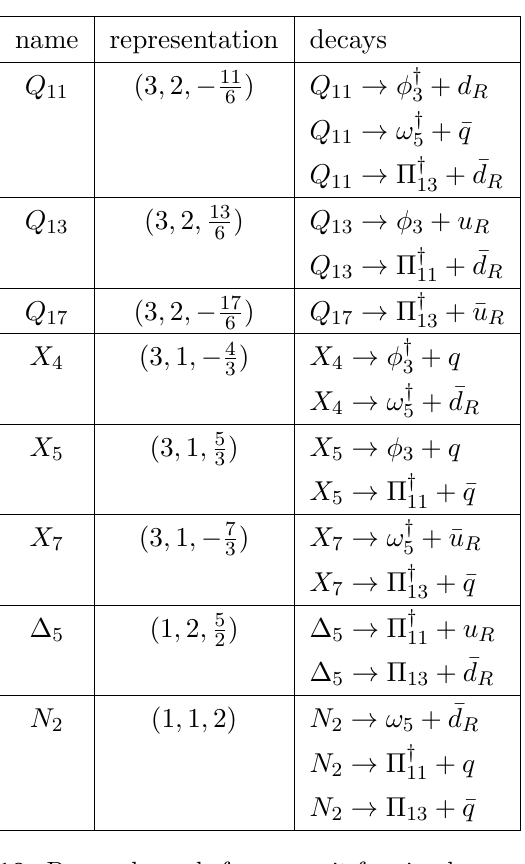
Table 10. Decay channels for non-exit fermion loop particles.